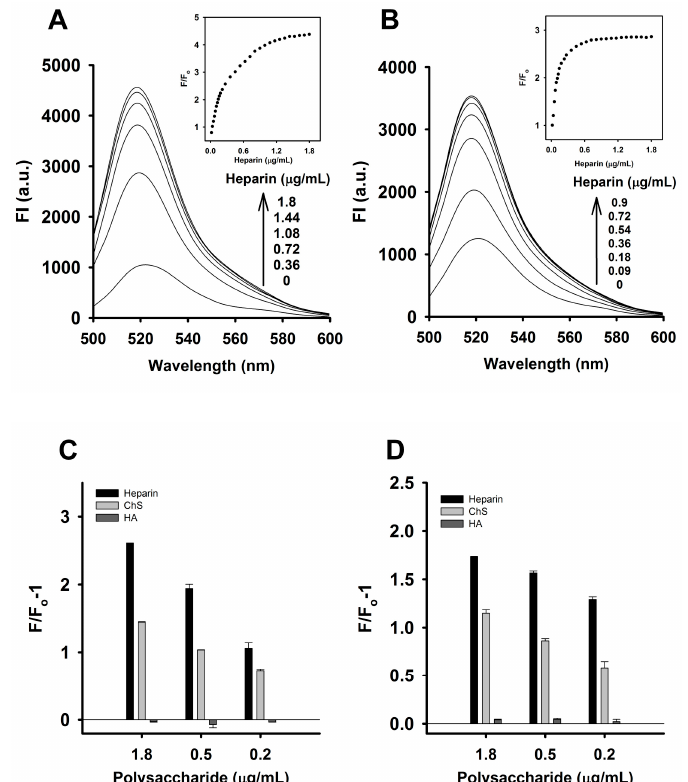
Figure 9. Effect of heparin on fluorescence intensity at 520 nm of CTX3-aptamer and CTX3-MB sensors: The arrows indicate the signal changes with increasing heparin concentrations. ( A ) fluorescence spectra of a solution of 20 nM aptamer and 300 nM CTX3 in the presence of indicated heparin concentrations. (Inset) The relative fluorescence intensity plotted against various heparin concentrations. ( B ) fluorescence spectra of a solution of 10 nM MB and 200 nM CTX3 in the presence of indicated heparin concentrations. (Inset) The relative fluorescence intensity plotted against various heparin concentrations. Fo and F corresponded to the fluorescence intensity of FAM at 520 nm in the absence or presence of heparin, respectively. Changes in the fluorescence intensity of ( C ) CTX3-aptamer and ( D ) CTX3-MB sensors upon the addition of heparin, chondroitin sulfate (ChS) and hyaluronic acid (HA). Fo and F corresponded to the fluorescence intensity of FAM at 520 nm as measured from CTX3-aptamer and CTX3-MB sensors in the absence or presence of indicated heparin, ChS and HA concentrations.